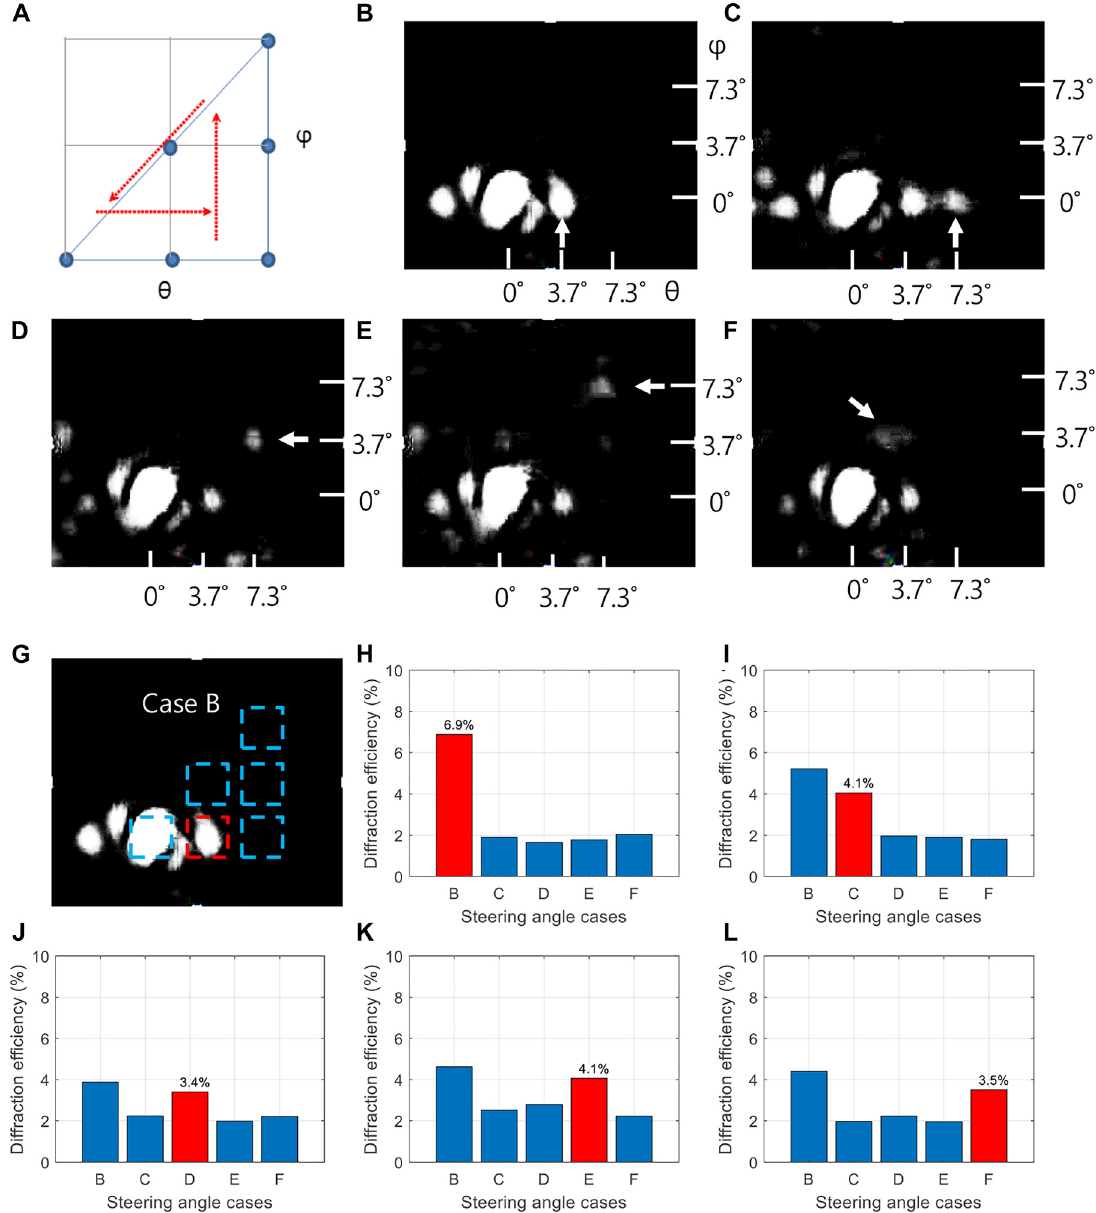
Figure 5: Experimental demonstration of two-dimensional beam steering. (A) Thecoordinatesystemof ( θ , φ ) forthe beamsteeringspots.(B) – (F) Far- fi eldimagesof lightre fl ectedfromactivemetasurface arraydevice, showingtwo-dimensionalbeamsteeringin( θ , φ ) overtherangeof ± 7.3 ° , i.e.,the fi vetargetangles:(3.7 ° , 0 ° ),(7.3 ° ,0 ° ), (7.3 ° ,3.7 ° ) (7.3 ° ,7.3 ° ), and (3.7 ° , 3.7 ° ) for (B), (C), (D), (E), and (F), respectively. (G) The steering case of (B) with the solid rectangle denoting the region of diffraction. (H) – (L) Diffraction ef fi ciency bar plots corresponding to (B) – (F),